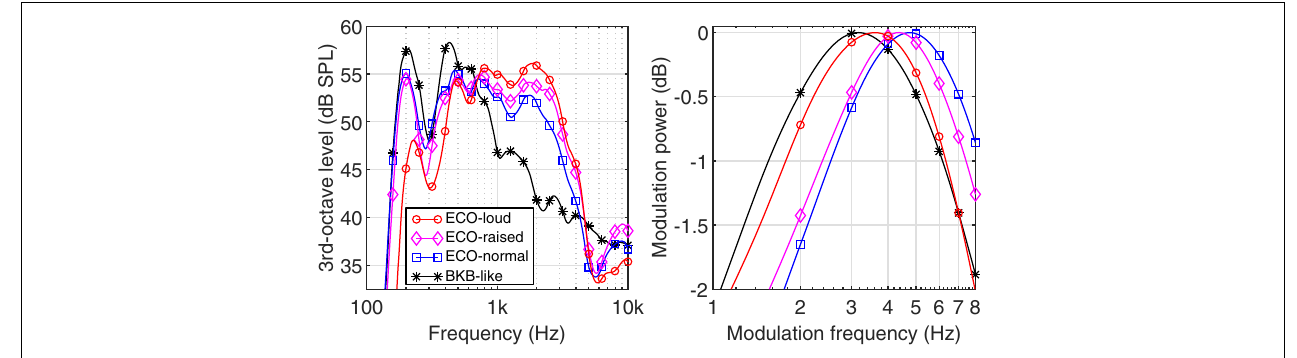
FIGURE 2 | Third-octave spectrum (left panel) and modulation spectrum (right panel) for the different speech materials and effort levels at an average broadband level of 65 dB SPL.